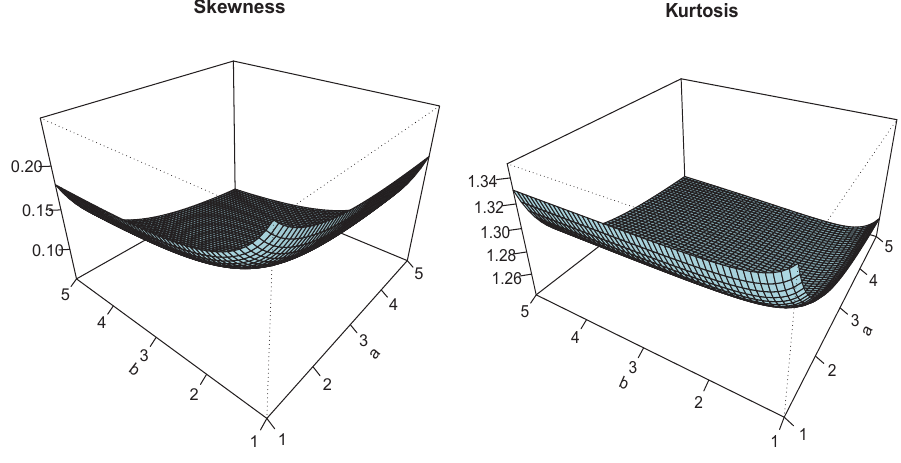
Figure 5. Plots of γ ∗